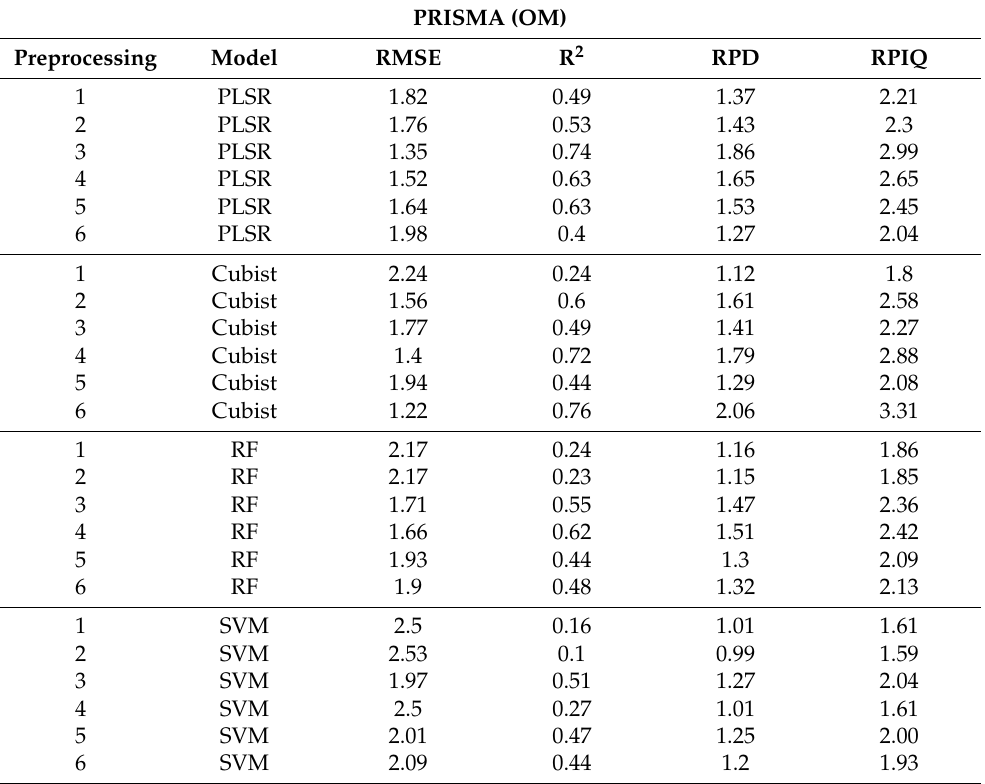
Table A3. Statistical evaluation of the models used to predict the soil organic matter (SOM) content from the PRISMA data.